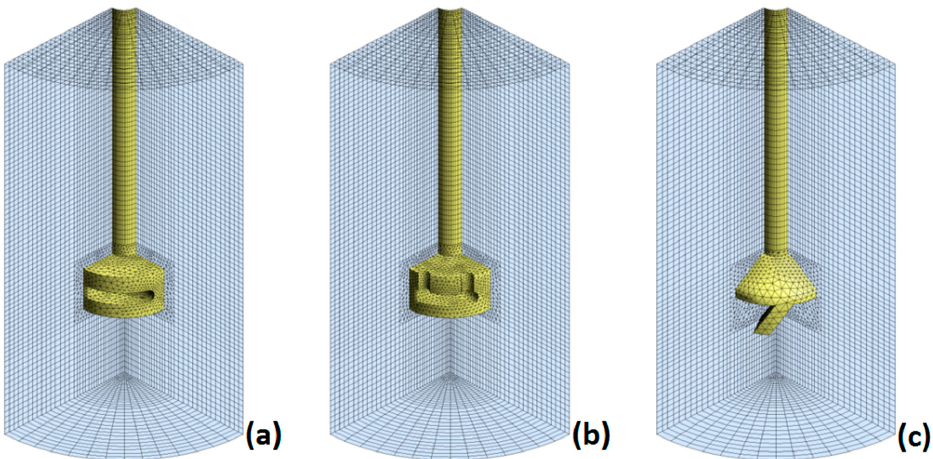
Figure 3. Meshes used in this work. ( a ) Impeller design A; ( b ) design B; ( c ) design C. Table 2. Characteristics of the different meshes for the three impellers tested in this work. Elements Geometry Total Hexahedric Tetrahedric Impeller design A 29,270 34,030 63,300 Impeller design B 29,270 31,610 60,880 Impeller design C 31,520 21,000 52,520